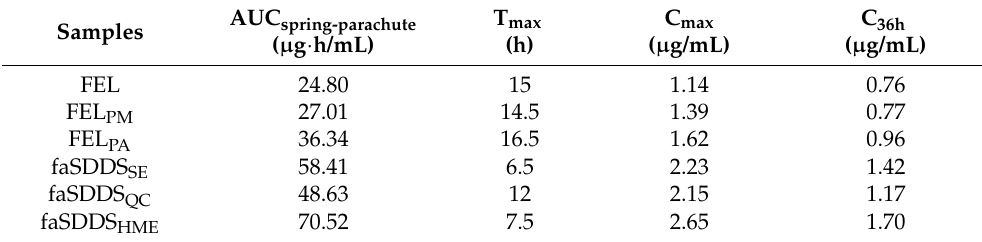
Figure 5. “Spring-parachute” profile of FEL-based samples including FEL (A), FEL PM (B), FEL PA (C), faSDDS SE (D), faSDDS MC (E), faSDDS HME (F) over a 36 h period at the equivalence of 30 mg FEL in PBS (pH 6.8) using dissolution apparatus. Table 1. Quantification parameters of the “spring-parachute” process for different FEL-related